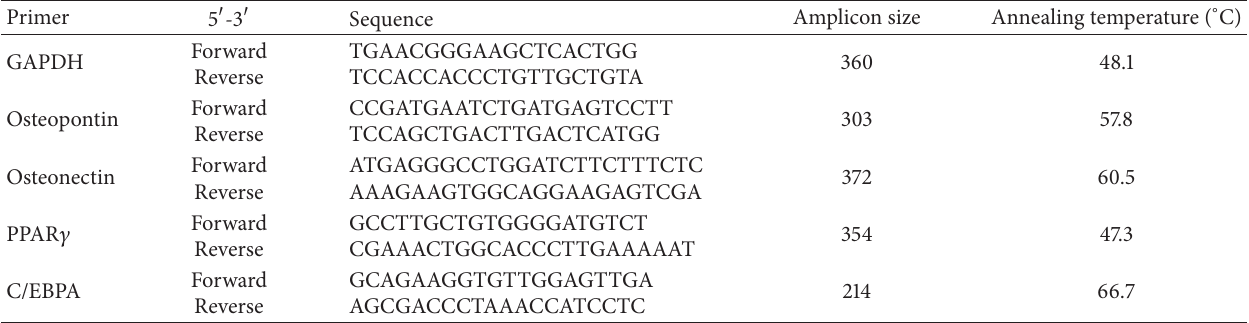
Table 2: Primer sequence for adipocyte and osteocytes.